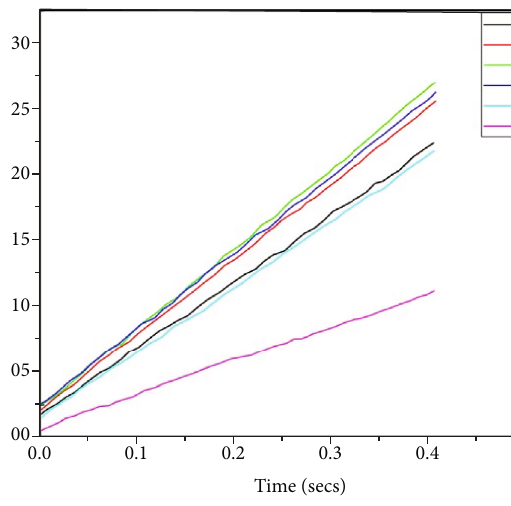
Figure 1: Flame front Kuramoto-Sivashinsky ((2D) DKS) equation. Naja fi khah